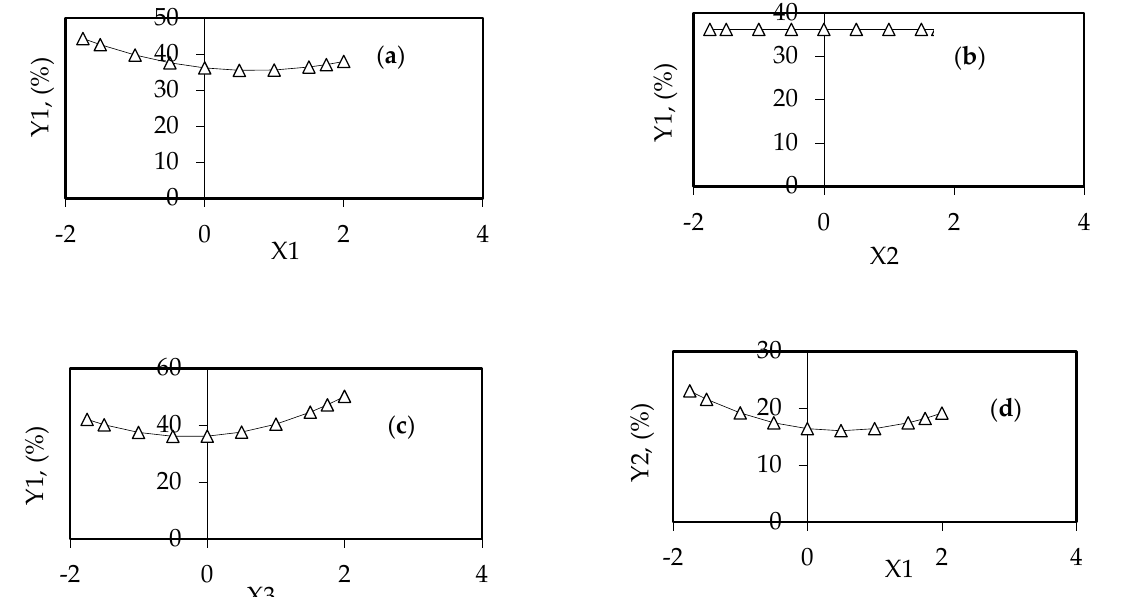
Figure 9. Variation in the WW suspended solids removal ( Y 1 ) vs. one independent variable ( X i ) (two variables were constant at the basic value): ( a ) Y 1 = Y ( X 1 ,0,0); ( b ) Y 1 = Y (0, X 2 ,0); ( c ) Y 1 = Y (0,0, X 3 ); and ( d ) variation of WW discoloration ( Y 2 ) vs. one independent variable ( X 1 ).